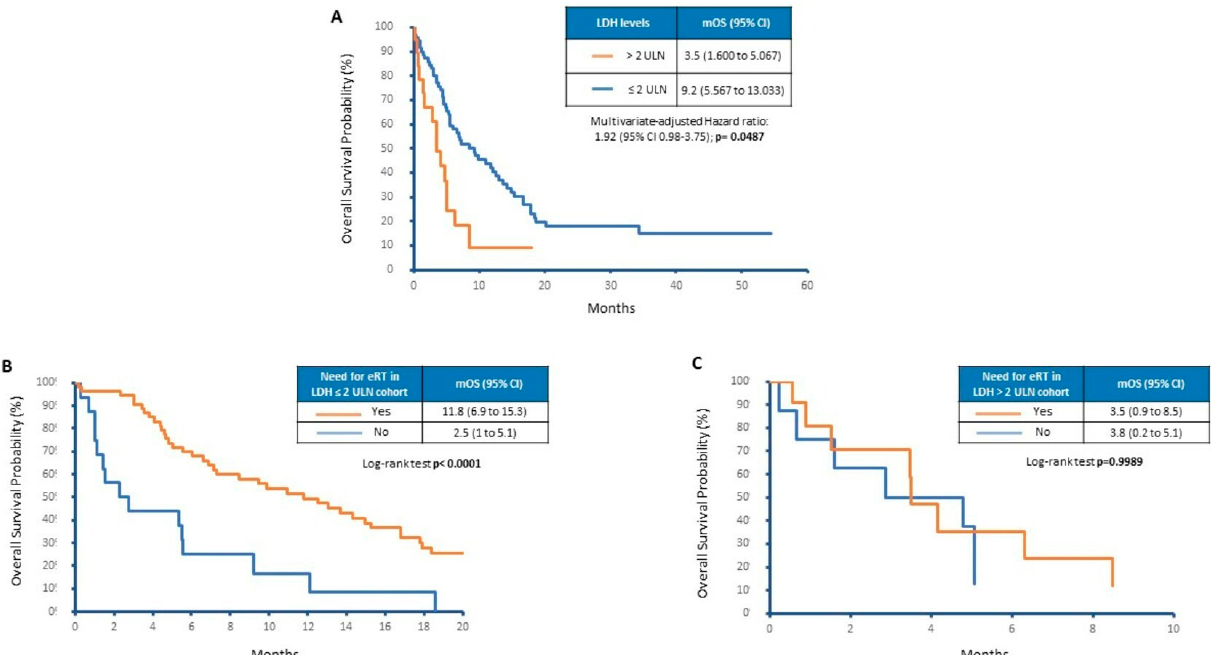
Figure 2. Overall survival of patients depending on ( A ) LDH levels, ( B ) eRT in LDH ≤ 2 ULN and ( C ) eRT in LDH > 2 ULN.